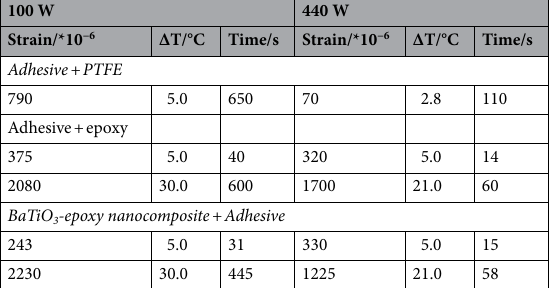
Table 3. Strain and temperature change measurements under 100 W and 440 W of three categories: FBG sensors bonded by adhesive to PTFE, FBG sensors bonded by adhesive to the neat epoxy, and FBG sensors bonded by adhesive to the epoxy nanocomposite with BaTiO 3 .